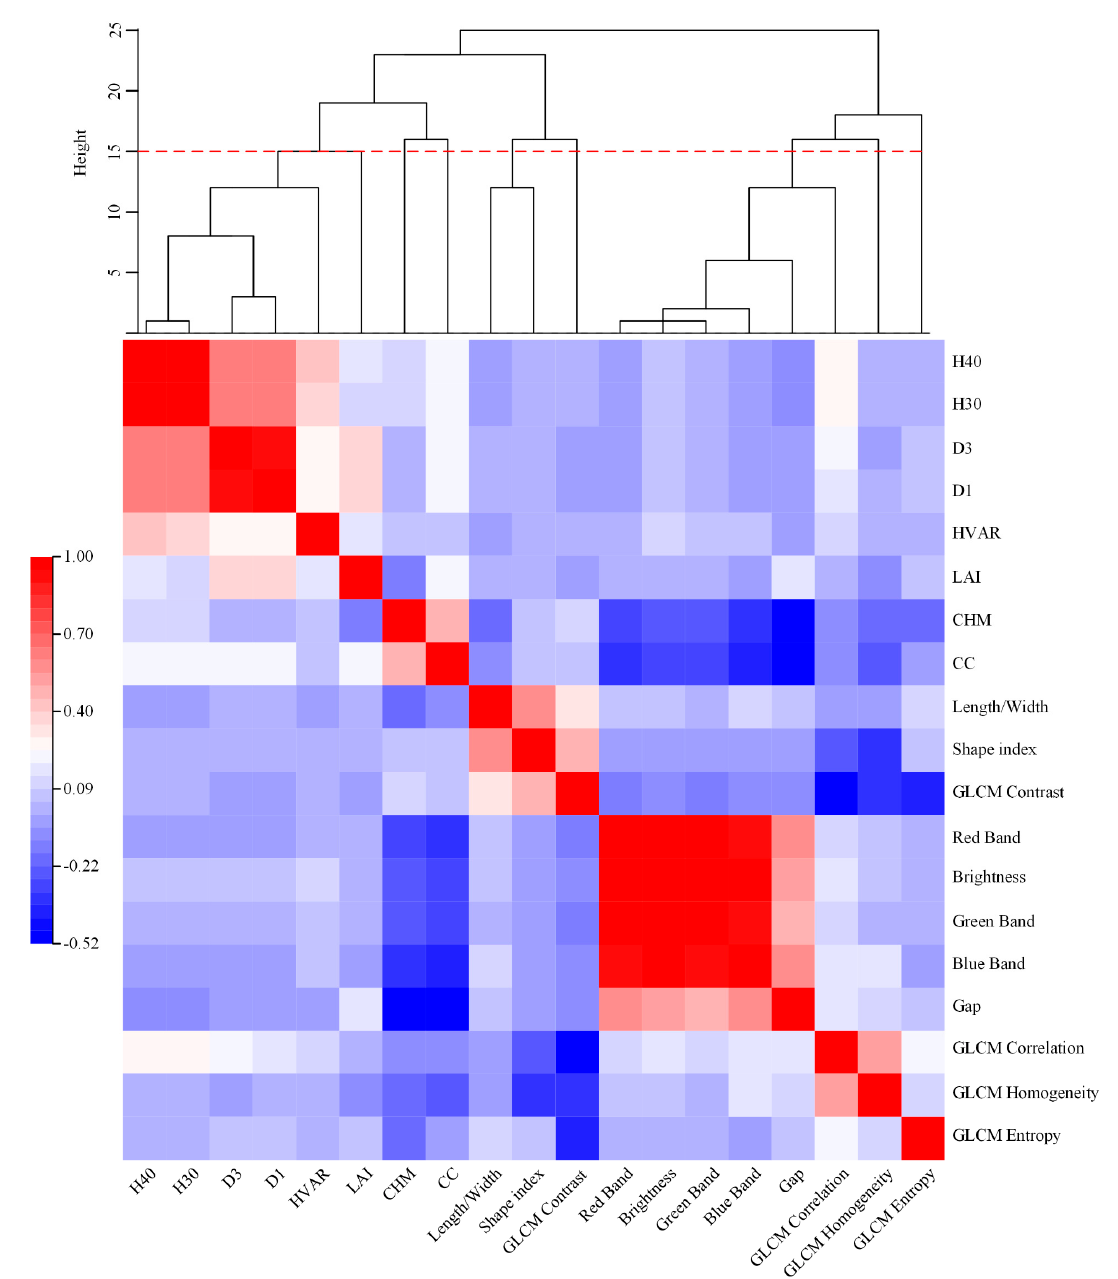
Figure 9. Hierarchical cluster plot and correlation matrix heatmap of important features in the LiDAR case with a point density of 10%. The 10% point density was the most cost-effective LiDAR point density found in this study. The upper graph represents hier- archical construction and distance among features; the below graph portrays pairwise correlation between